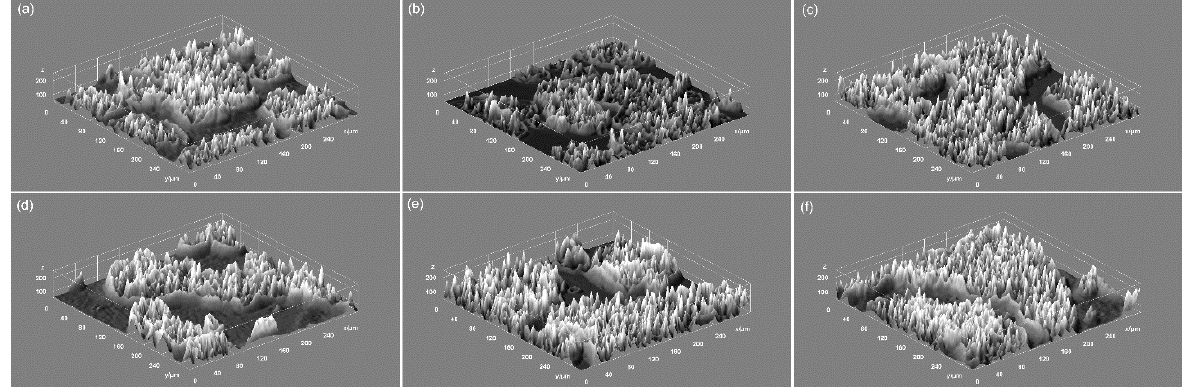
Figure 11. 3D representation of microscopic images of HepG2 control cells ( a – c ) at different time intervals (24, 48, and 72 h) and HepG2 cells grown on dextran thin films deposited on glass substrate ( d – f ) at different time intervals (24, 48, and 72 h).